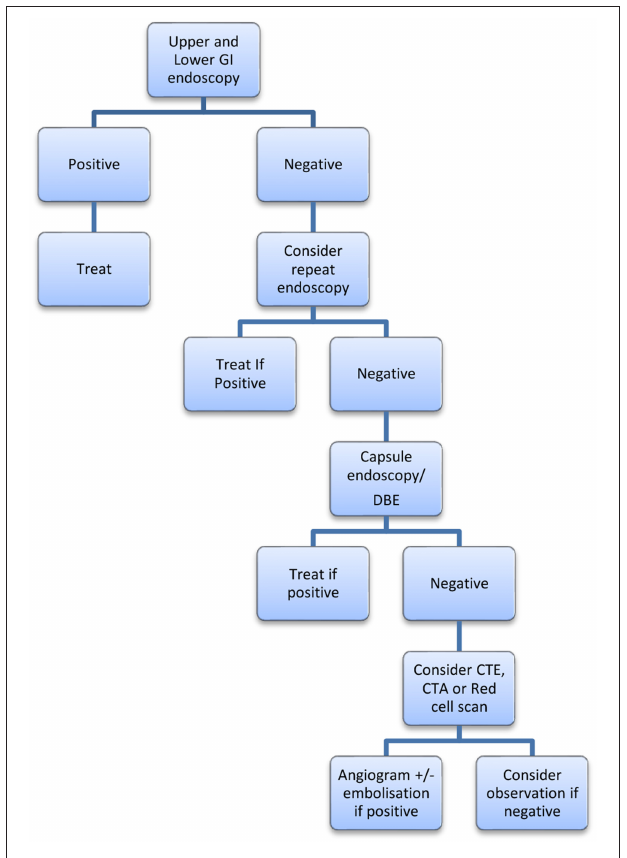
FIGURE 1 | Proposed algorithm for occult GI bleeding.